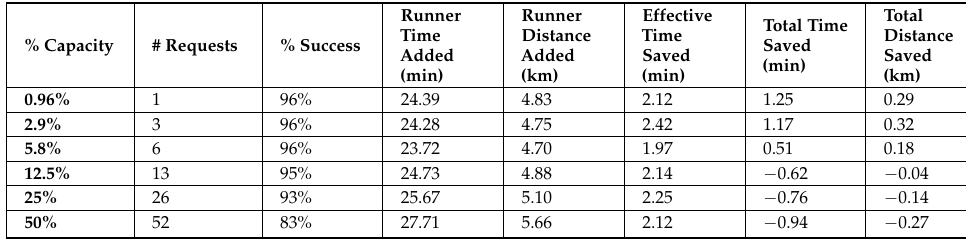
Table 6. Results from Time Square feasibility